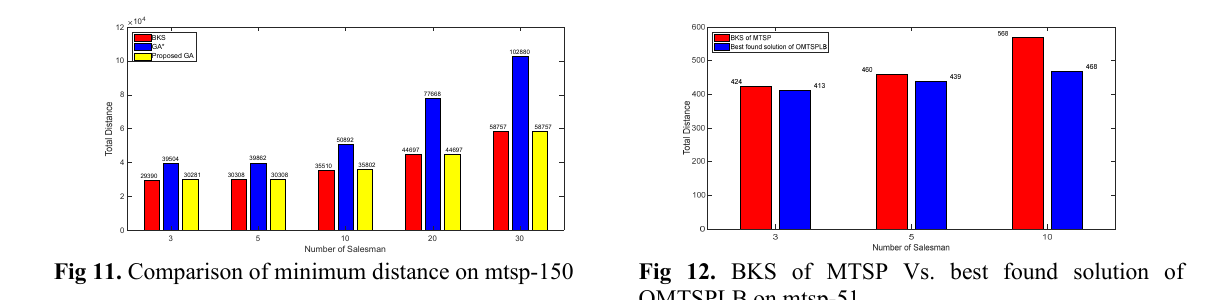
Fig 9. Comparison of minimum distance on mtsp-51 Fig 10. Comparison of minimum distance on mtsp-100